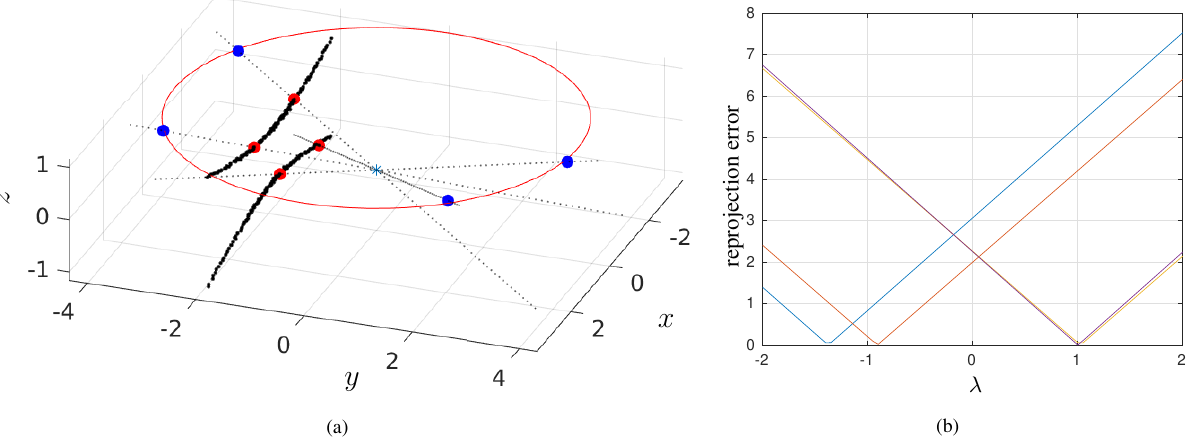
Figure 4. (a) shows sample points (blue) on C r in a one-to-one projectivity with corresponding measured points (red) and (b) shows the reprojection error for different λ i values for each of the four sample points.